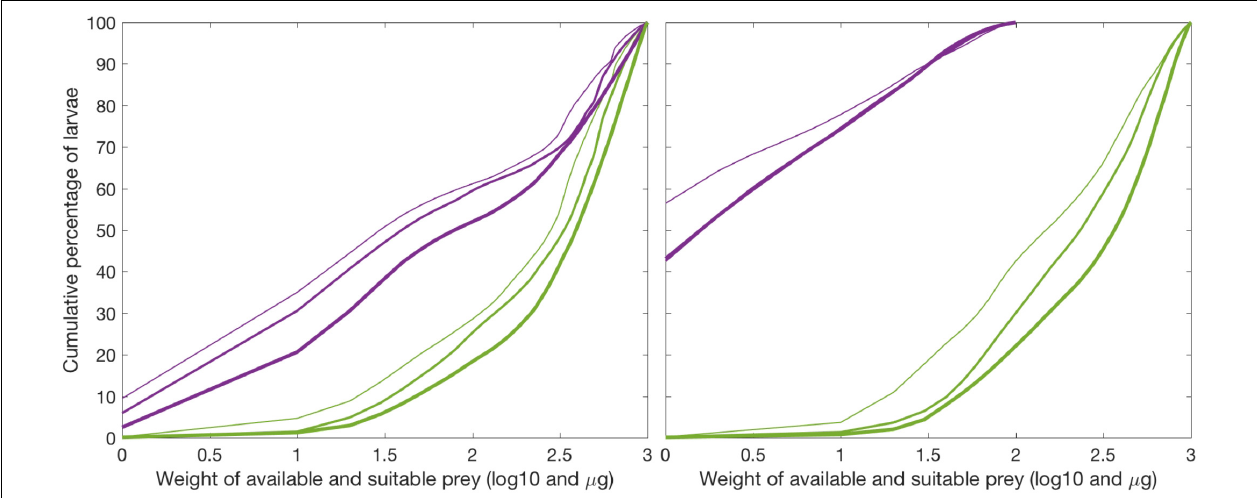
FIGURE 9 | Prey availability for starving larvae (left panel) during 1995, 2001, and 2002 (thin, medium, and thick line) accounting for suitable (magenta) and all (green) prey. Correspondingly (right panel) for non-starving larvae. E.g., left panel shows that about 43% of the larvae experiencing prey-limited growth is surrounded by between about 10–300 µ g per liter but none of these have suitable size for the larvae to enable